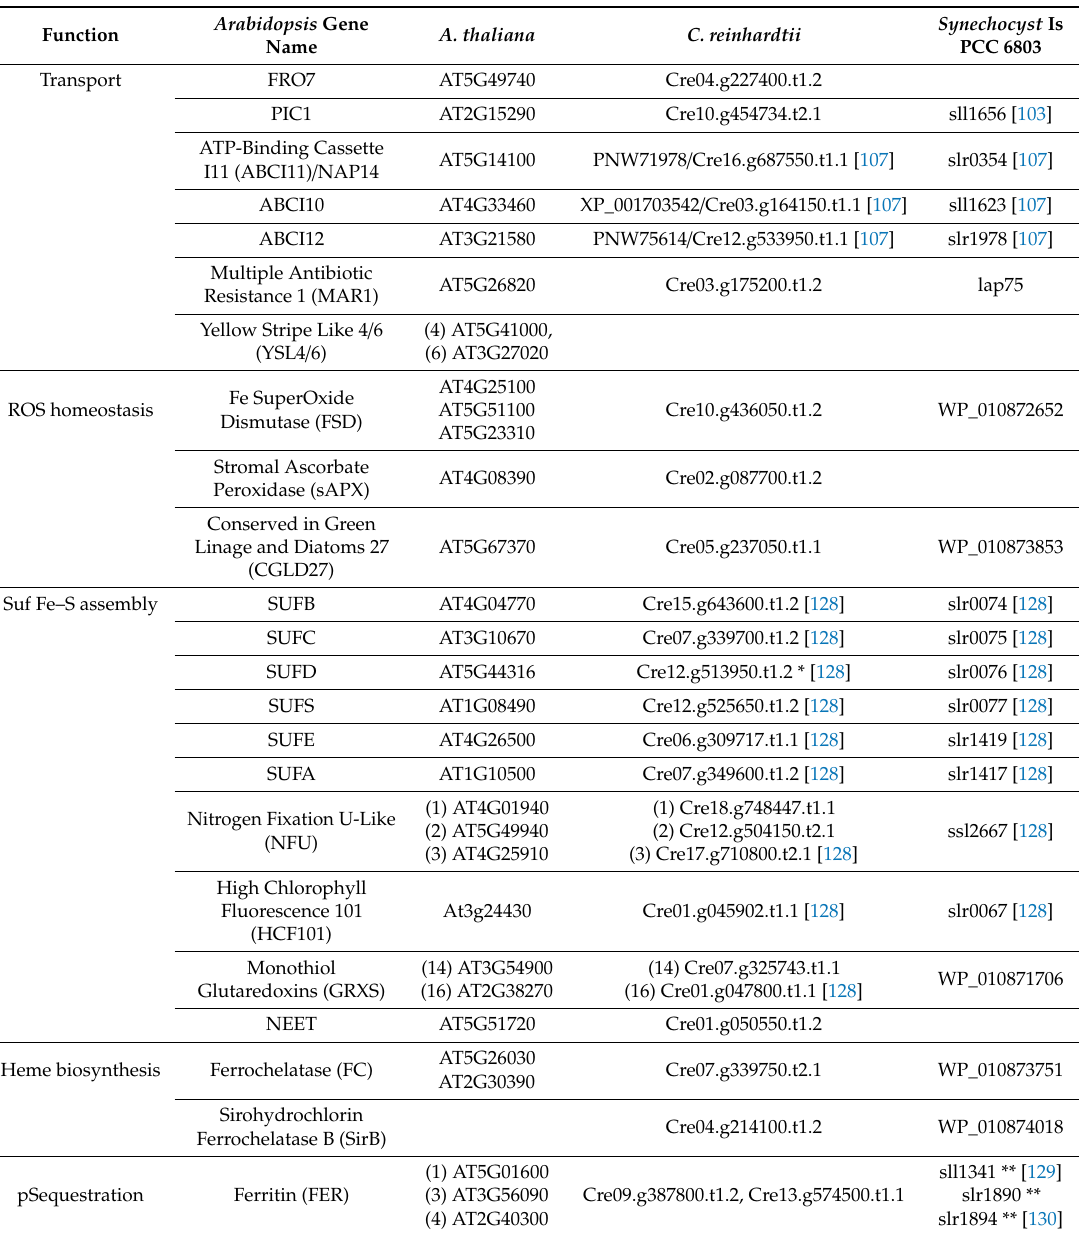
Table 1. Arabidopsis thaliana chloroplast Fe homeostasis genes and their Chlamydomonas reinhardtii and Synechocystis PCC 6803 (Cyanobacterial) orthologues. Arabidopsis protein name and ID are listed for plastid Fe homeostasis proteins discussed in this review. Studies that identified Chlamydomonas and Cyanobacterial orthologues for these proteins are referenced next to the gene name. In cases where an orthologue has not been previously identified in the literature, the Arabidopsis protein sequence was used as a query sequence in NCBI BLAST. Orthologues were determined if the Chlamydomonas and Cyanobacterial sequences had at least 20% sequence similarity for at least 50% of the query sequence. When possible, Cyanobacterial gene names are listed for Synechocystis PCC 6803. Otherwise, the NCBI gene ID is